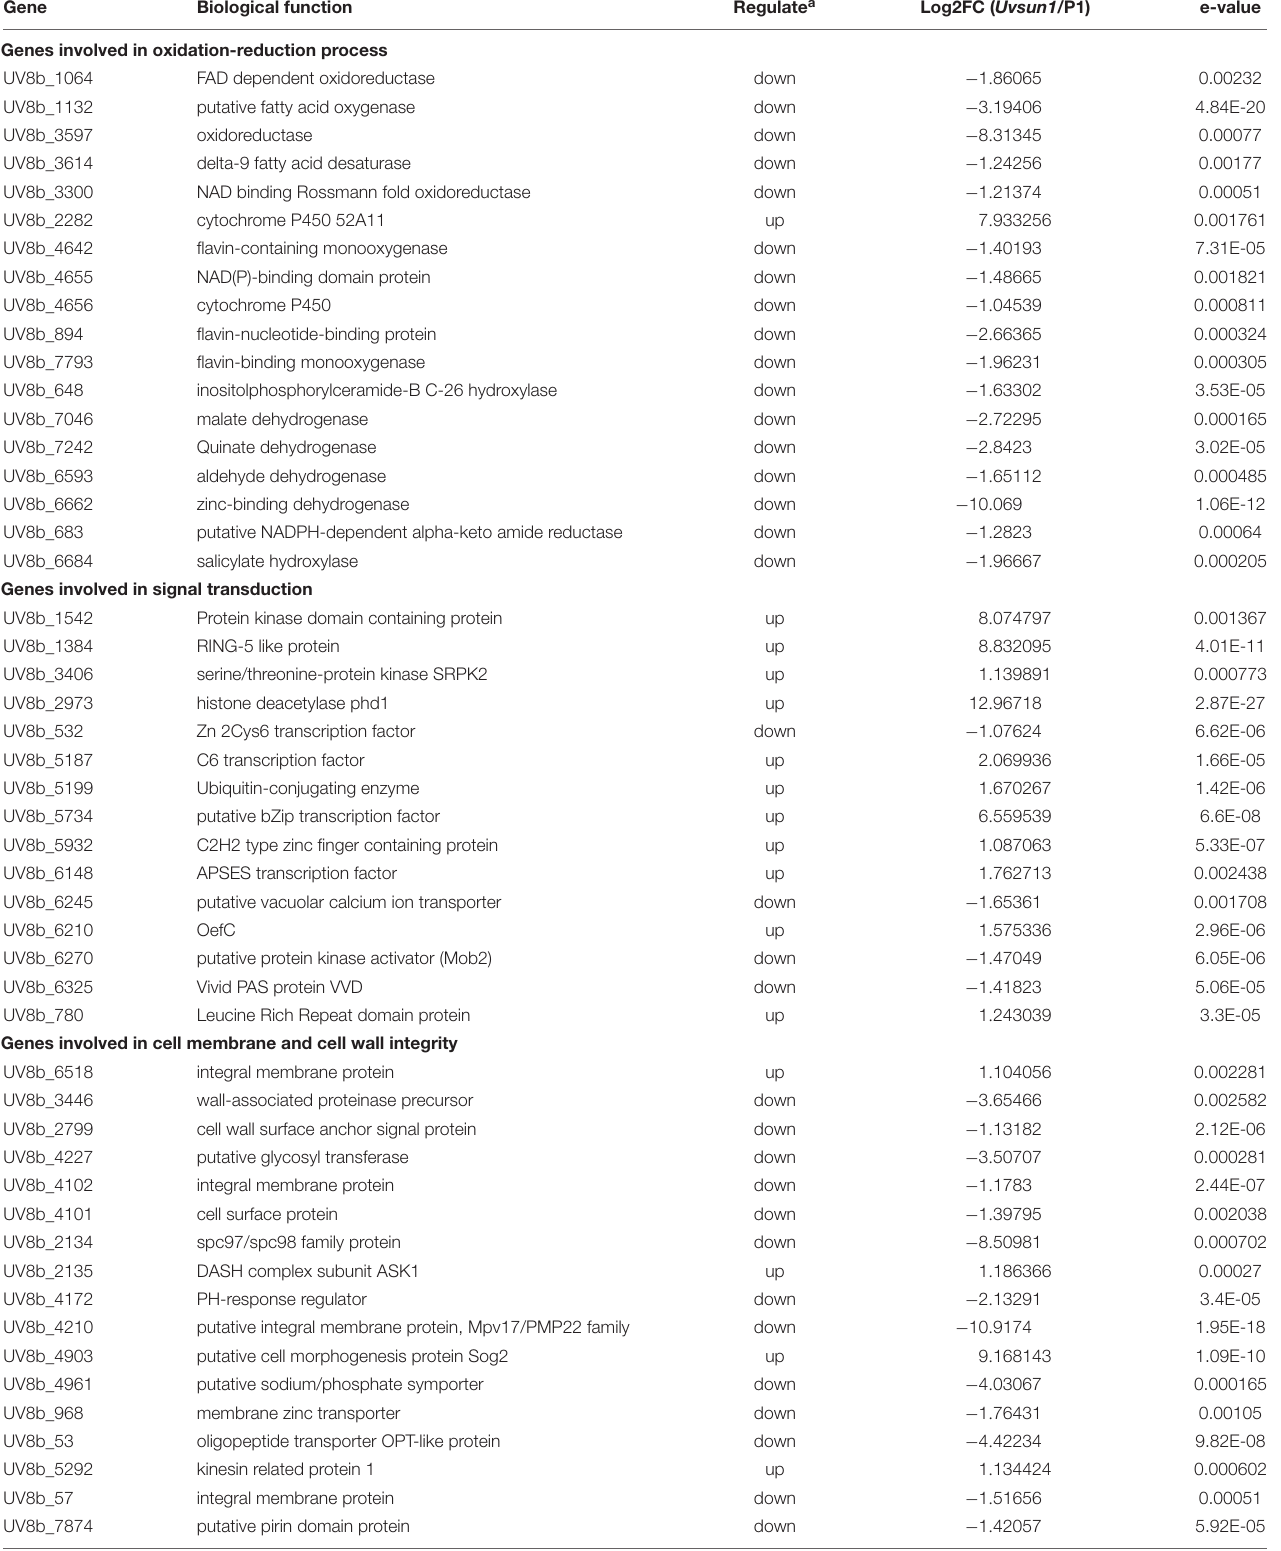
TABLE 2 | A list of genes that may be affected by